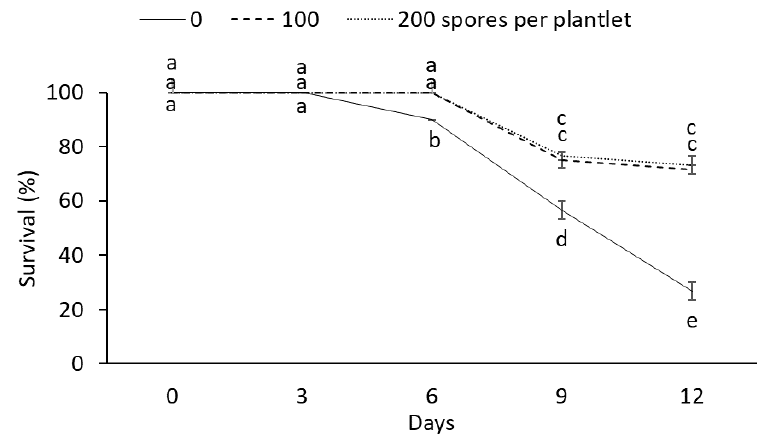
Figure 1. Effect of different doses (0, 100, and 200 spores per plantlet) of arbuscular mycorrhizal fungi ( Glomus intraradices ) on the survival rate of sugarcane plantlets ( Saccharum spp. cv Mex 69-290) evaluated under drought stress during acclimatization stage. Results are shown as mean ± standard error. Means with different letters (a, b, c, d or e) are significantly different (Tukey, p < 0.05).